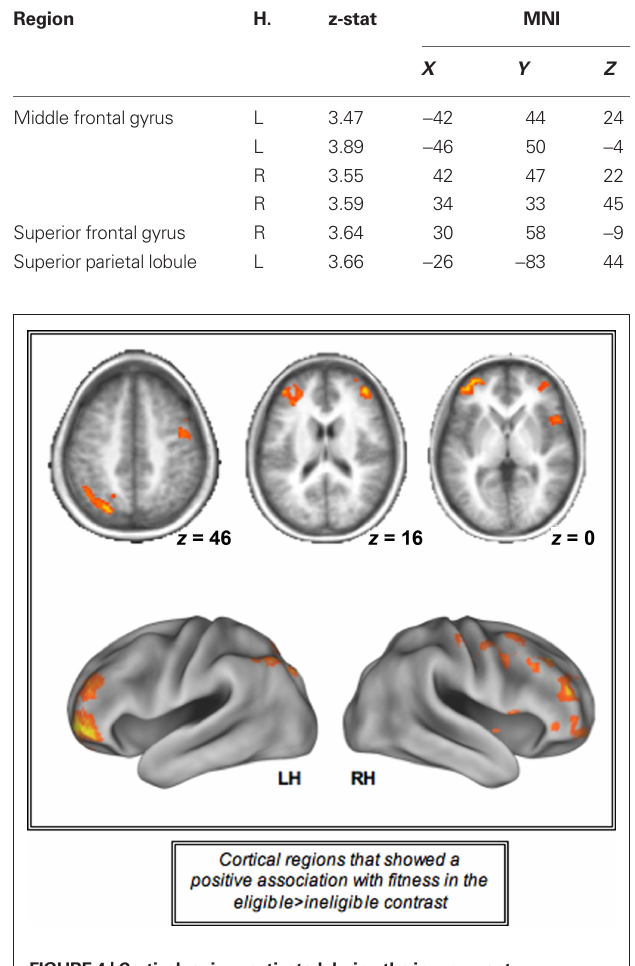
Figure 4 | Cortical regions activated during the incongruent- eligible > incongruent-ineligible contrast that showed a positive association with cardiorespiratory fitness. All axial slices are presented in neurological orientation (L = L, R = R).